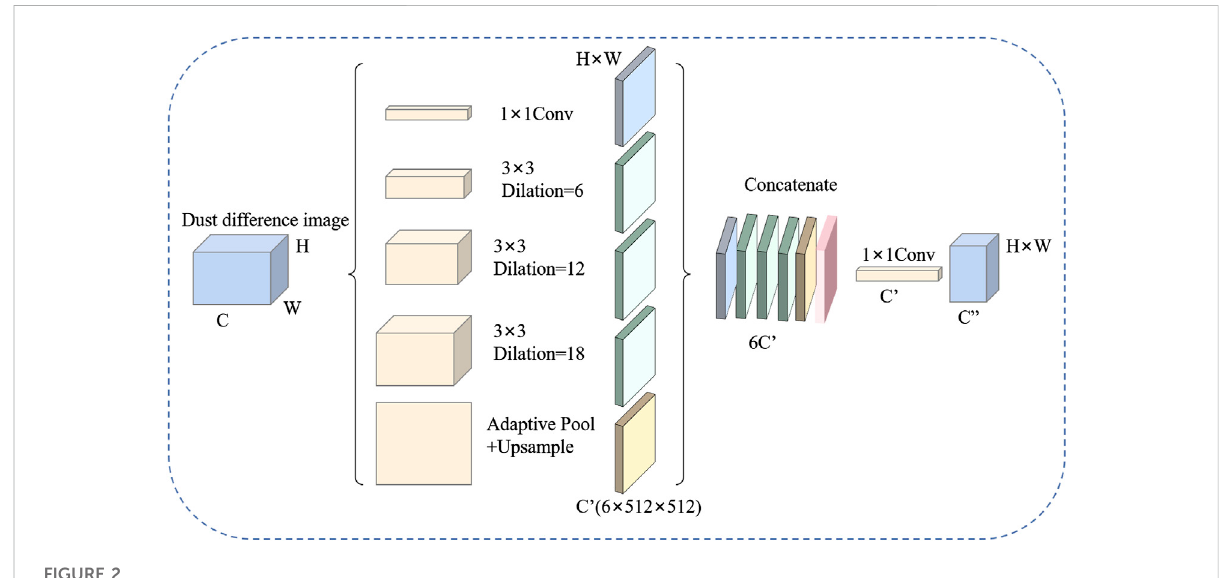
FIGURE 2 Atrous spatial pyramid pooling.